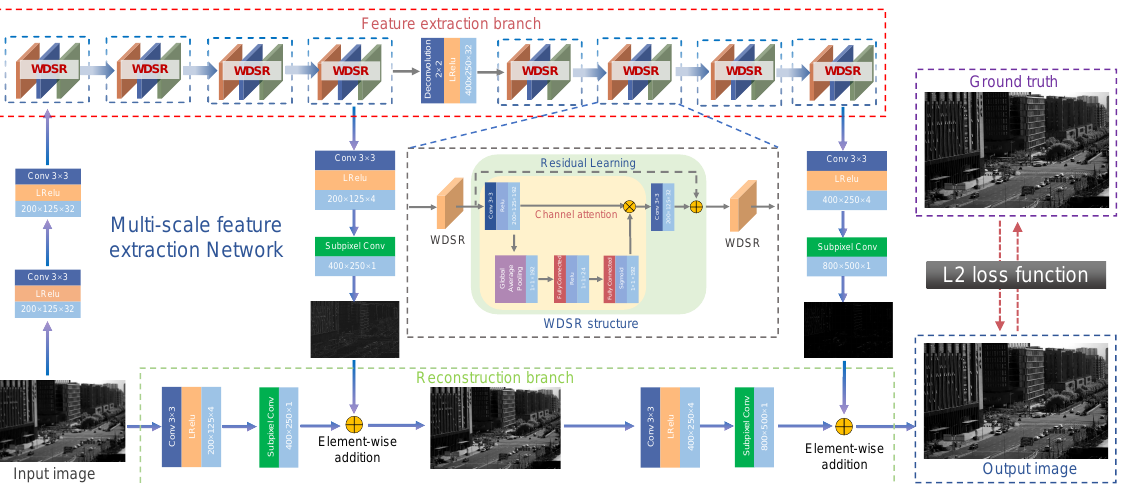
Figure 3. Structure diagram of the super-resolution deep learning network based on multi-scale feature